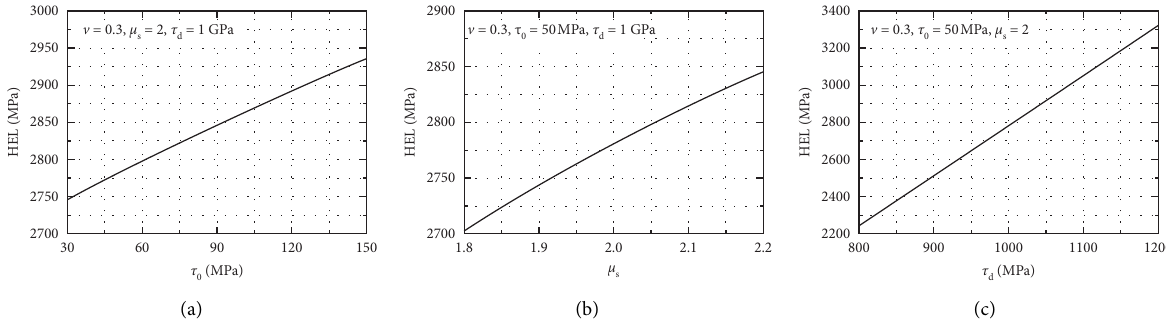
Figure 3: Sensitivity analysis of HEL with τ τ d � 1 GPa). (c) HEL vs. τ d ( ] � 0.3, τ 0 � 50MPa, μ s �